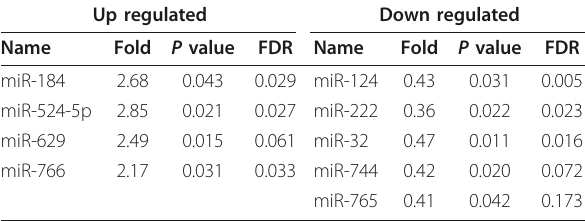
Table 3 miRNAs differentially expressed in macro- vs. micro- GH-secreting pituitary adenomas Up regulated Down regulated